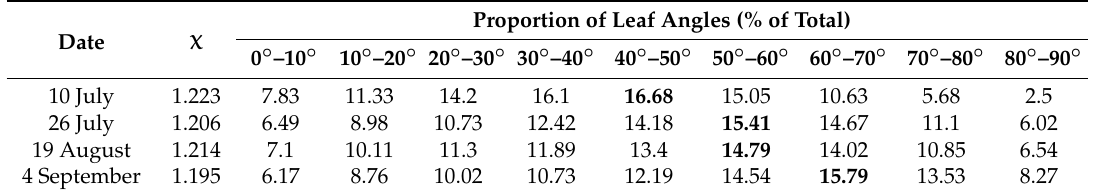
Table 4. Proportion of the leaf angles (in 10 ◦ intervals) on the four phenological dates.